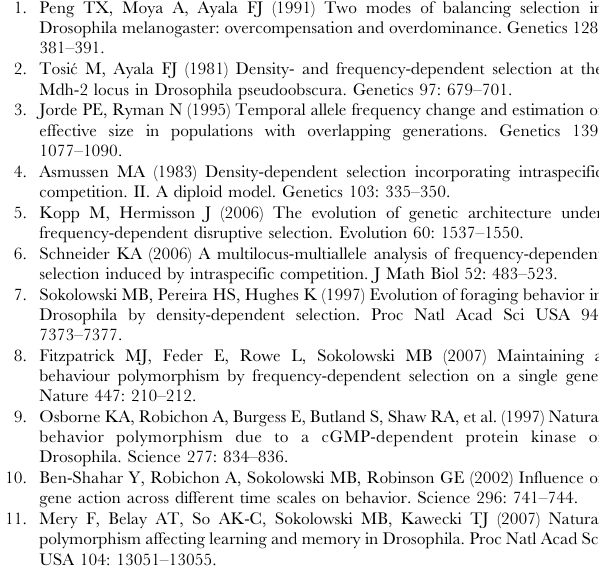
Figure S4 Primers used in this study and analysis of kinase inhibitors in biochemistry experiments. S2 cells were stably transfected with an expression vector bearing the